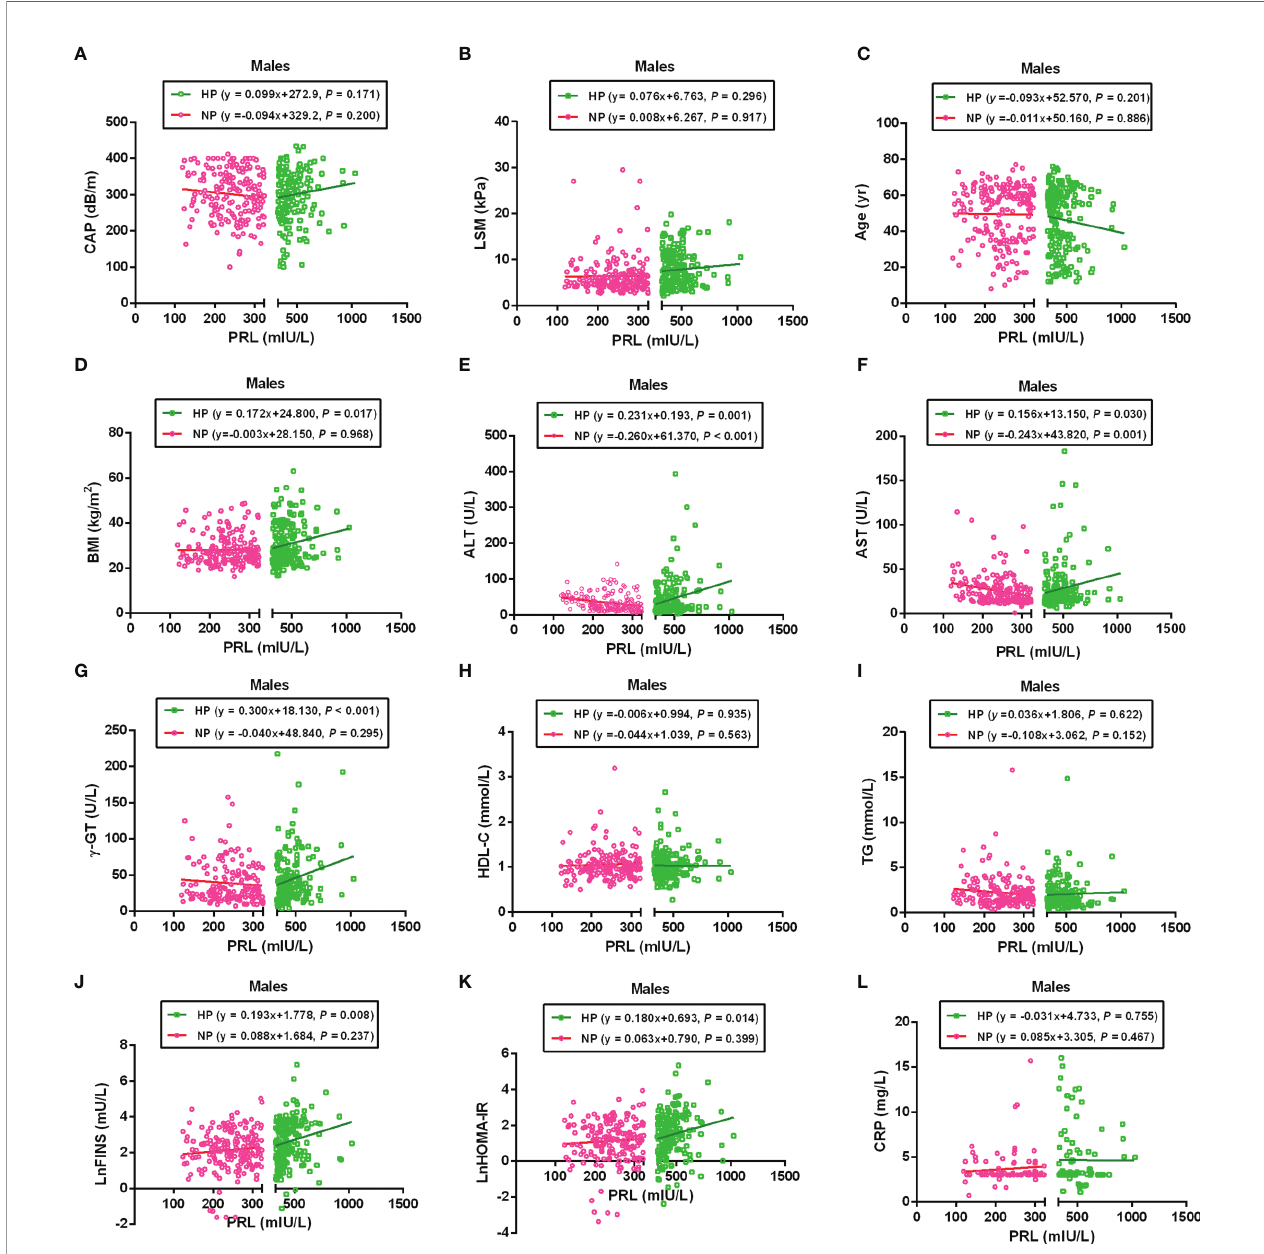
FIGURE 5 | Linear regression analysis shows the relationship between PRL and MAFLD-related risk factors among males. These factors included CAP (A) , LSM (B) , Age (C) , BMI (D) , ALT (E) , AST (F) , g -GT (G) , HDL-C (H) , TG (I) , LnFINS (J) , LnHOMA-IR (K) , and CRP (L) . The serum PRL was signi fi cantly negatively associated with ALT and AST in the NP group but positively associated with BMI, ALT, AST, g -GT, LnFINS, and LnHOMA-IR in the HP group. PRL, prolactin; CAP, controlled attenuation parameter; LSM, liver stiffness measurement; ALT, alanine transaminase; AST, aspartate aminotransferase; g -GT, gamma-glutamyl transferase; HDL-C, high-density lipoprotein cholesterol; TG, triglyceride; FINS, fasting insulin; HOMA-IR, homeostasis model assessment of insulin resistance; CRP, C-reactive protein. Non-normally distributed data were log-transformed before analysis. P -values < 0.05 were accepted as statistically signi fi